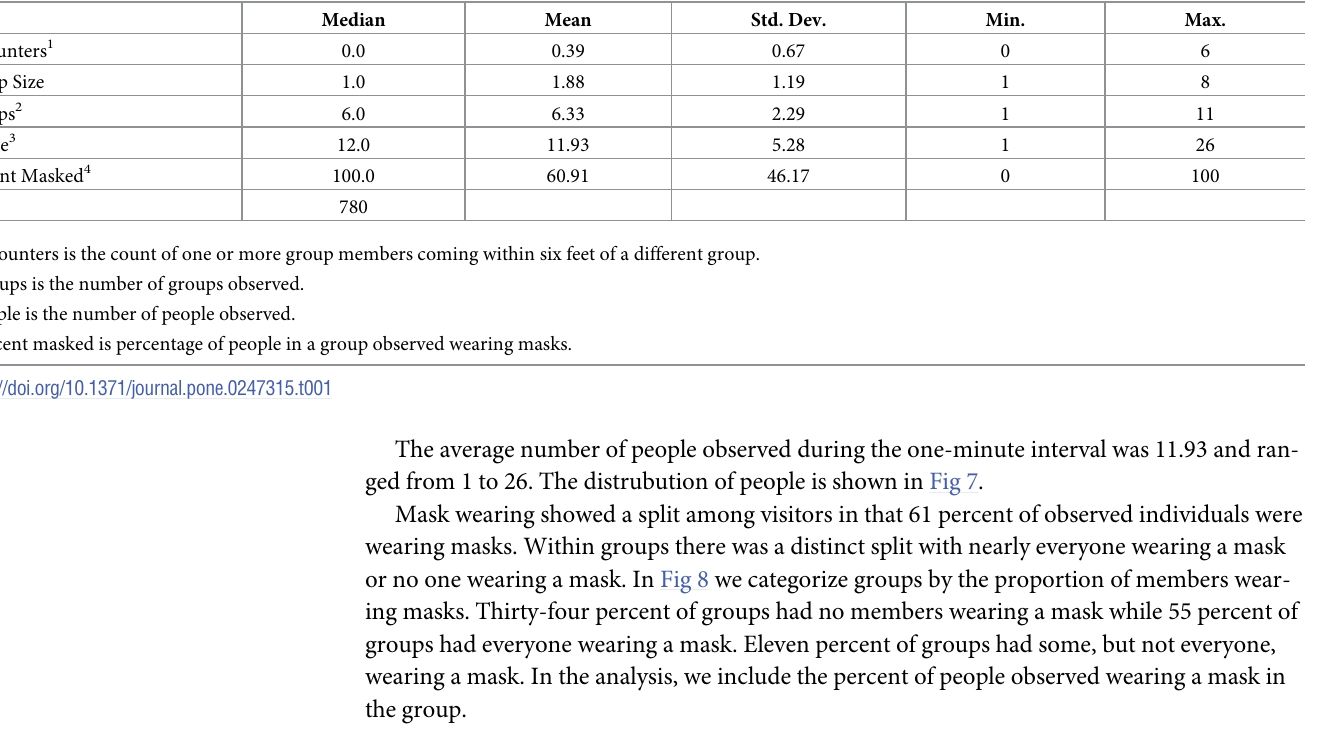
Table 1. Descriptive statistics of observations.